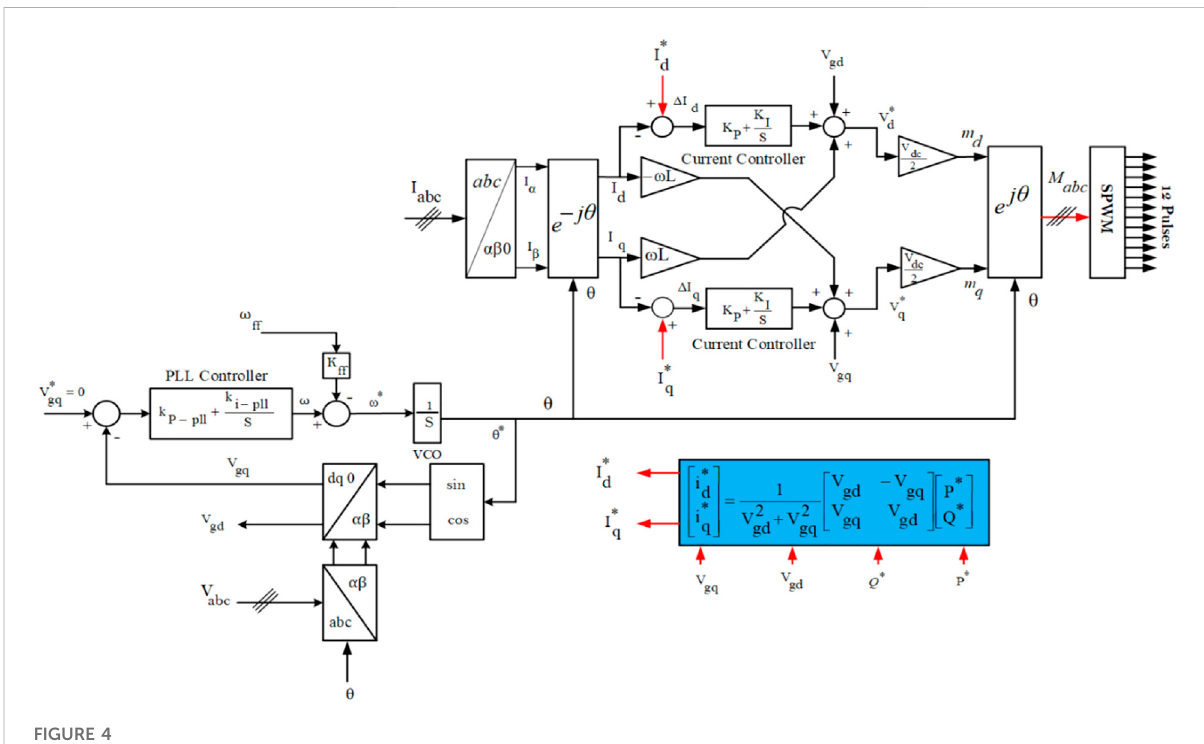
FIGURE 4 Open-loop control